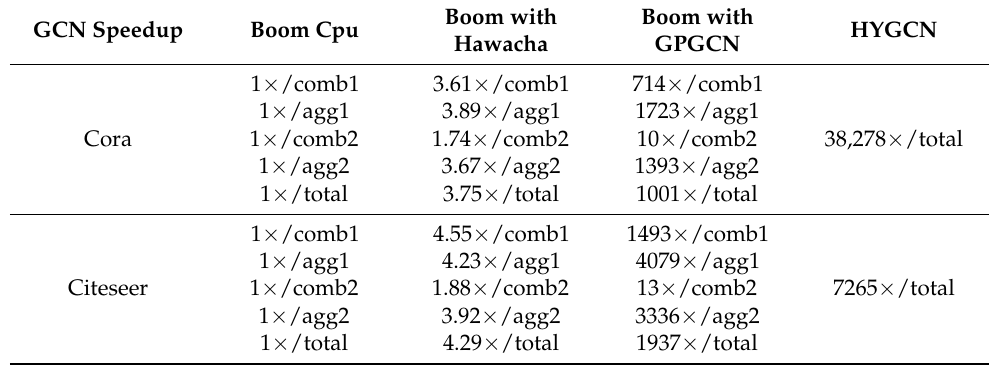
Table 9. The GCN execution speedup of different hardware with different datasets.